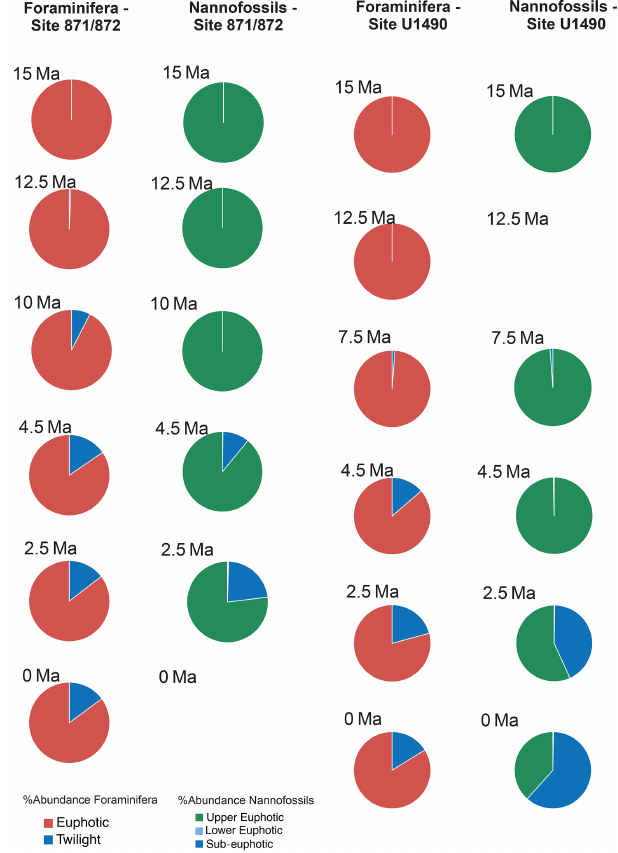
Figure 3. Foraminiferal and nannofossil ecogroup abundance at Sites 871/872 and